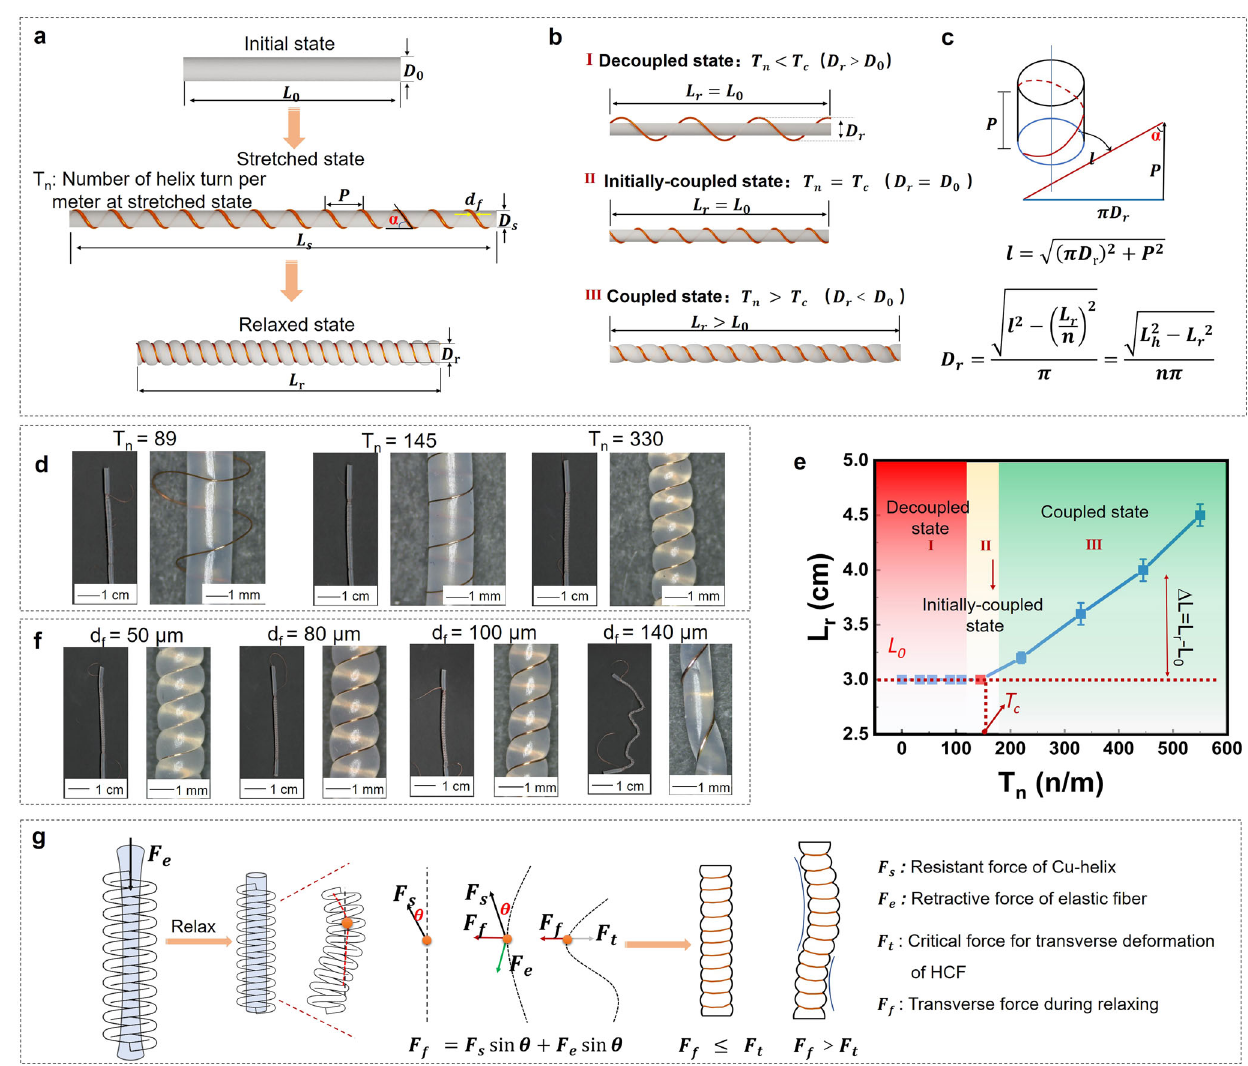
Fig. 2 Fabrication studies and structure analysis of the HFC. a De fi nition of the controlled parameters for the fabrication of the HFC. b Schematic diagram of the different states for the Cu wire-wrapped-elastomer composites, including the decoupled, initially coupled and strongly coupled states. A high-quality HFC is successfully fabricated only when the two components are mechanically coupled. c Illustration of the trigonometric relationship for the Cu helix- conformation structures at coupled states. d Photographs of wire-wrapped-elastomer composites with different T n values corresponding to different coupling states from decoupled, initially coupled and strongly coupled states. e The dependent behavior of the length of the wire-wrapped-elastomer at relaxed state, L r , on the T n value, which can distinguish the different states as introduced above. f Photographs of HFCs prepared by wrapping Cu wires with different diameters. g Force analysis for understanding the uncontrollable bending behavior of HFC with thick Cu